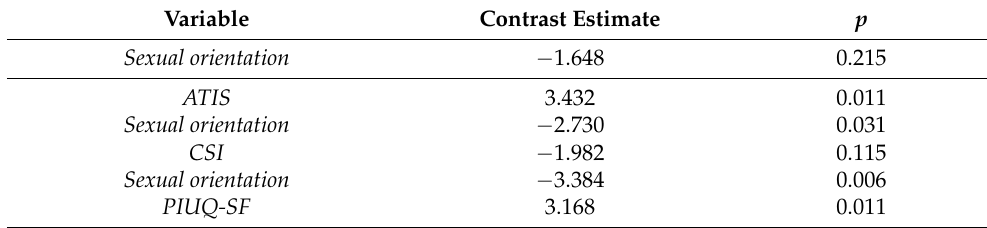
Table 5. Contrast differences for sexual orientation, attitude toward infidelity, couple satisfaction, and problematic internet use on social media infidelity-related behaviors. Variable Contrast Estimate p Sexual orientation − 1.648 0.215 ATIS 3.432 0.011 Sexual orientation − 2.730 0.031 CSI − 1.982 0.115 Sexual orientation − 3.384 0.006 PIUQ-SF 3.168